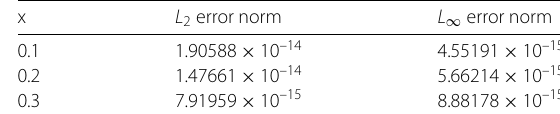
Table 1 L 2 and L ∞ error norm when β = 1